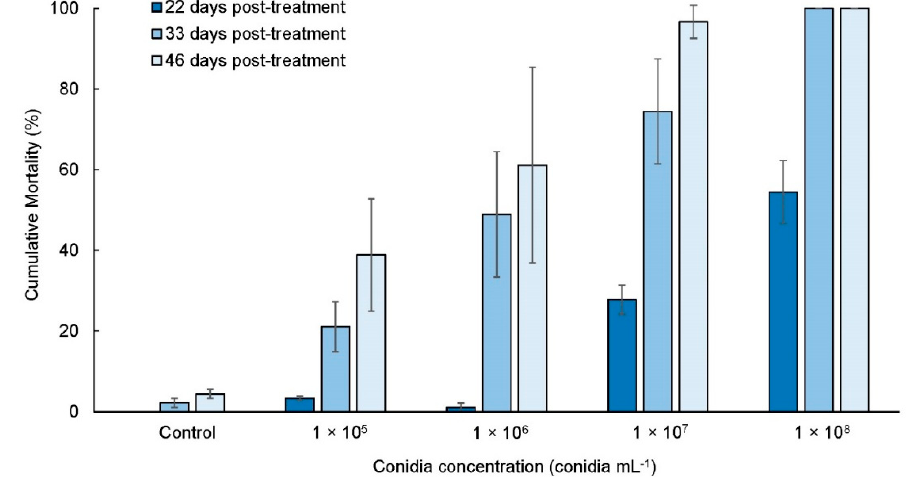
Figure 5. Mean cumulative mortality data (%) with standard errors of Hylobius abietis adults from the feeding damage bioassay after their inoculation with conidia suspensions of Beauveria bassiana strain AMEP20.